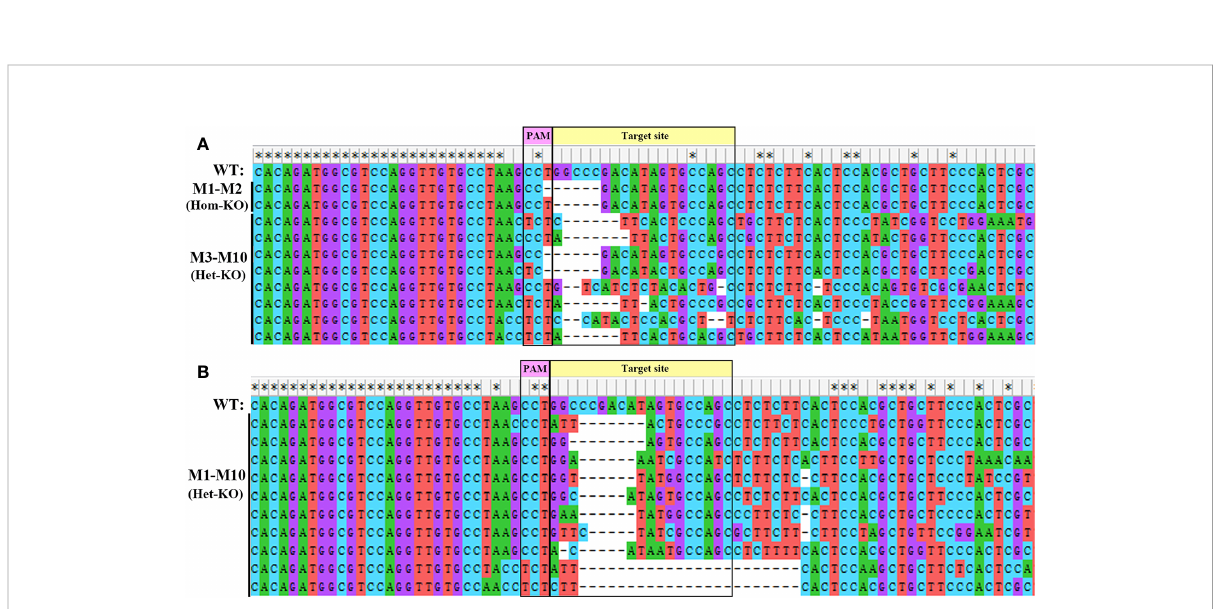
FIGURE 6 Ten different types of deletion mutants generated in EcILP -injected embryos at nauplius stage (A) and zoea stage (B) . Purple rectangles represent protospacer adjacent motif (PAM) sequences. The yellow rectangle is the 20 bp genomic target site. Deletions are indicated by dashed lines. Bases under asterisks represent fully conserved bases. WT, wild-type. Types of homozygous and heterozygote deletions are marked. The corresponding sequencing chromatograms are shown in Figure S1 and S2.